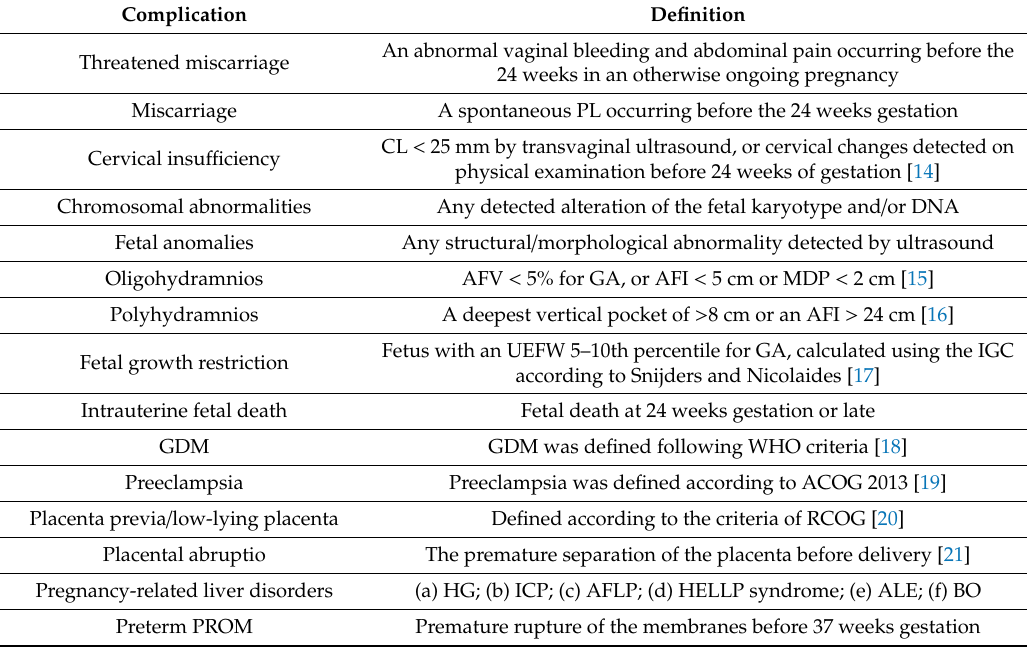
Table 1. Definitions of pregnancy